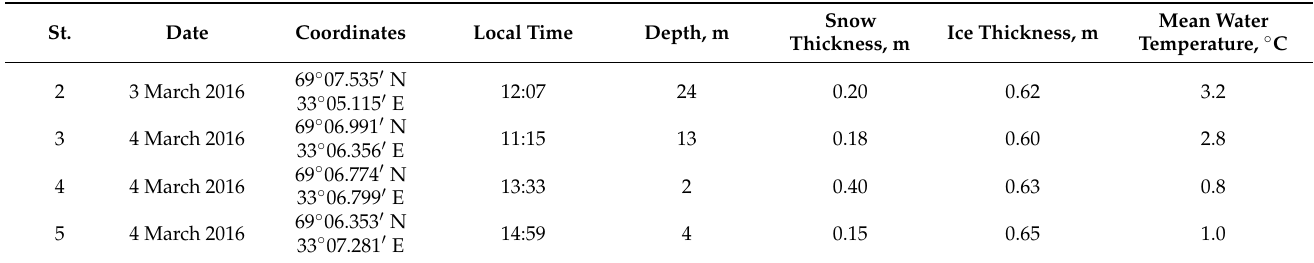
Table 1. A list of zooplankton sampling stations and environmental variables in Lake Kulonga in March 2016. St.